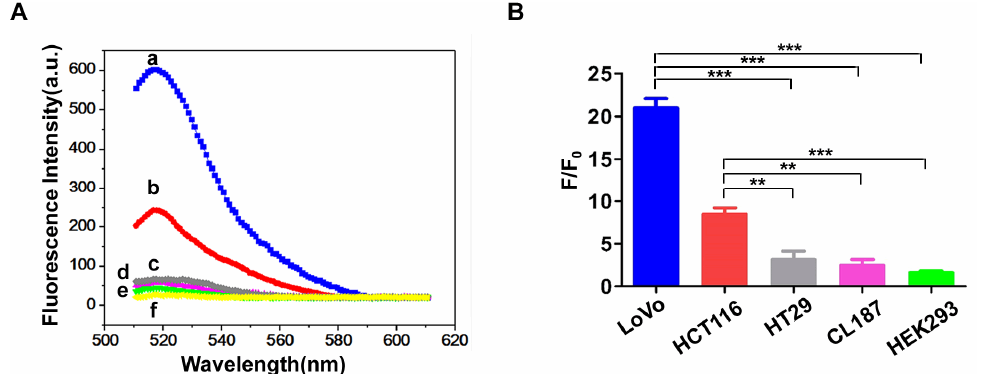
Figure 5. Specificity of FAM-W3-GO fluorescent aptasensor for mCRC cells. ( A ) The fluorescence spectra of different cell lines incubated with FAM-W3-GO: (a) LoVo cells, (b) HCT116 cells, (c) HT29 cells, (d) CL187 cells, (e) HEK293 cells, and (f) PBS. ( B ) The fluorescence intensity rate ( F/F 0 ) of FAM-W3-GO fluorescent aptasensor in the presence of LoVo, HCT116, HT29, CL187, and HEK293 cells, respectively. **, p < 0.01; ***, p < 0.001. In addition, FAM-W3-GO was used to detect LoVo cells in mixed cell samples. Ra- tios of LoVo cells to HEK293 cells in mixed cells were 0%, 5%, 20%, 50%, and 100%. Fig- ure 6 shows that decreasing HEK293 cells were observed in the low-fluorescence region, while cell numbers of the high-fluorescence region gradually increased with a rising number of LoVo cells in the cell mixture. It was suggested that FAM-W3-GO enables ef- ficient and specific detection of mCRC cells from mixed cell samples.